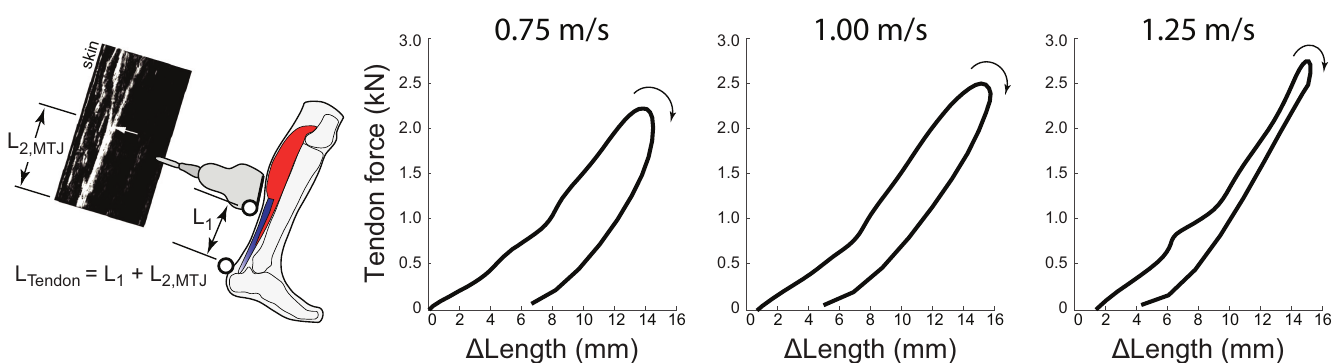
Fig 2. Direct MTJ estimation method and tendon work loops during walking. Left: The Direct MTJ method estimates tendonlength changesby summing the instantaneous position of the ultrasoundtransducer with respect to the tendon’s insertion, L 1 , and the displacement of the MTJ within the transducer’s field of view, L 2, MTJ . In this method the ultrasound transducer is positionedover the MTJ. Right: This Direct MTJ method, appliedto the LG MTU, yields negativework loops on average, for all walkingspeeds tested. Hysteresis losses were estimated to decreasewith increasing speed, from an averageof 49% at 0.75 m/s to 11% at 1.25m/s. Average (inter-subject) mean results are depicted ( N =